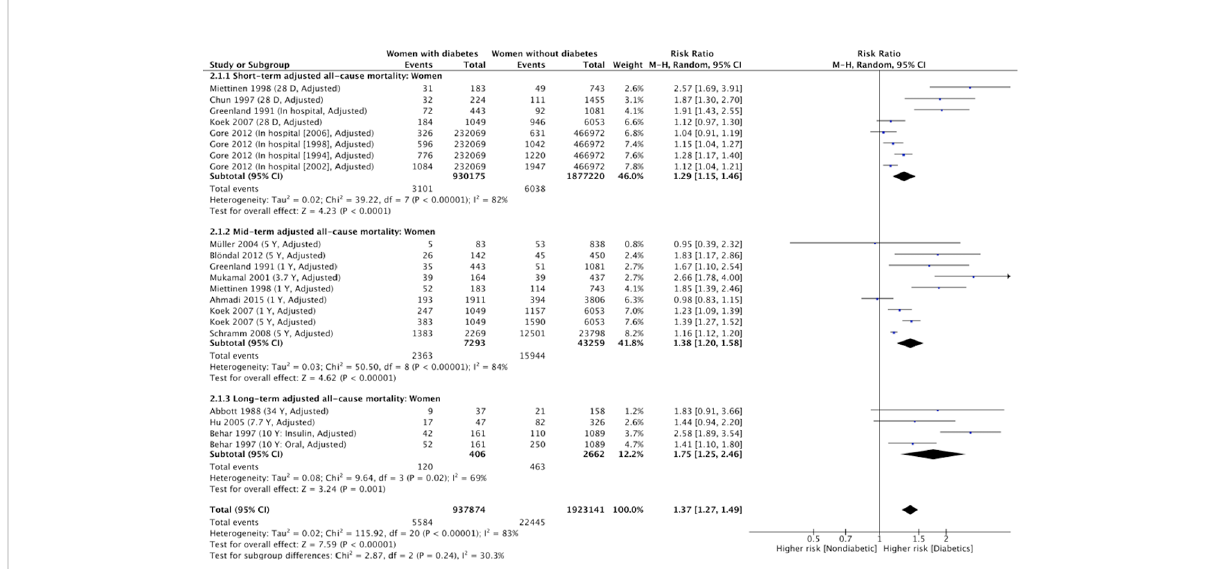
FIGURE 5 Summary of adjusted short-term, mid-term and long-term risk estimates for post-AMI all-cause mortality in women with diabetes compared to women without diabetes. (Data extracted from 13 studies and including of total of 937,874 women with diabetes and 1, 923,141 women without